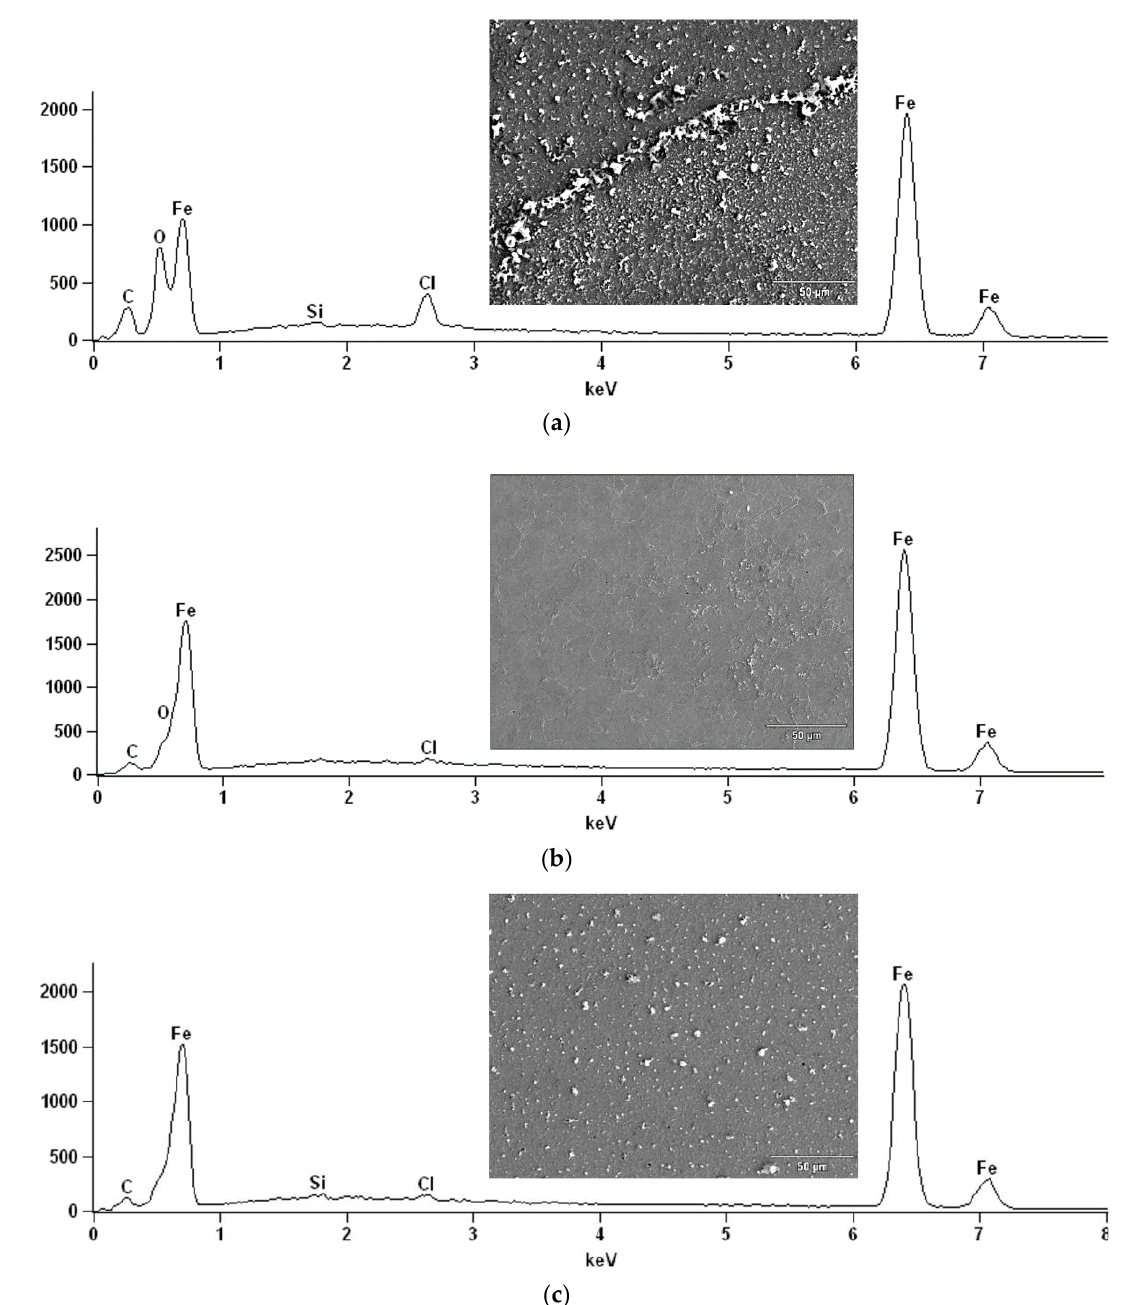
Figure 7. SEM-EDS micrographs of the API X52 steel surface after 2 h of immersion in 0.5 M HCl: ( a ) without IL and in the presence of ( b ) [THDA + ][ − AA] and ( c ) [THDA + ][ − AD].